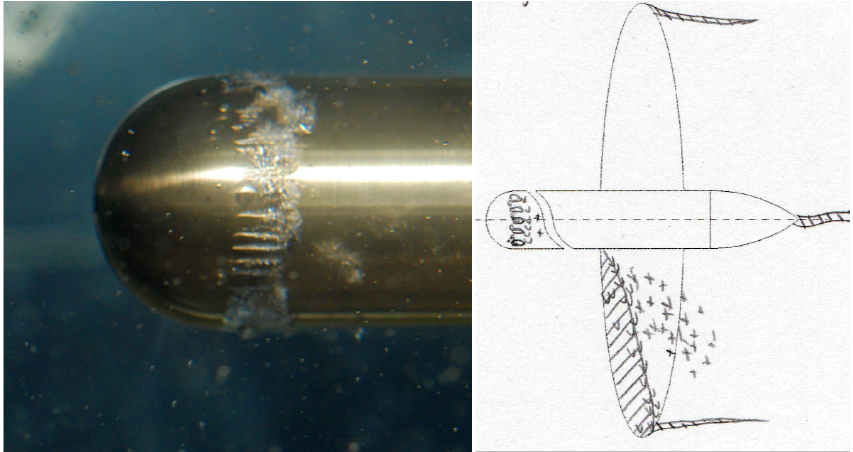
Figure 17. Cavitation extent observed in the experiments— U ∞ = 8 m/s and σ = 0.53 from [49]. Photograph of the head of the cavitator ( left ); sketch of the mean cavitation extent on the cavitator ( right ).